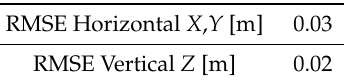
Table 4. Simulation landing position